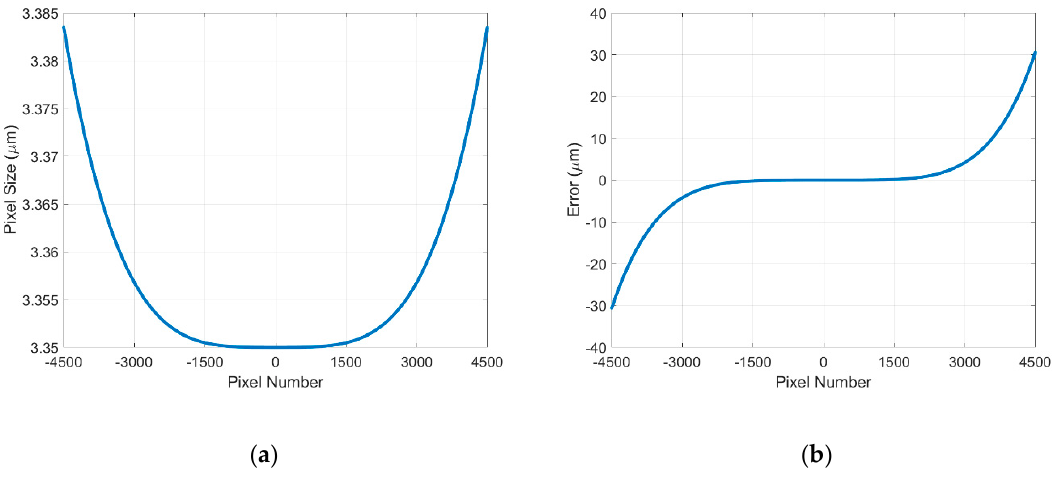
Figure 7. ( a ) Lens distortion curve; ( b ) Position error curve.